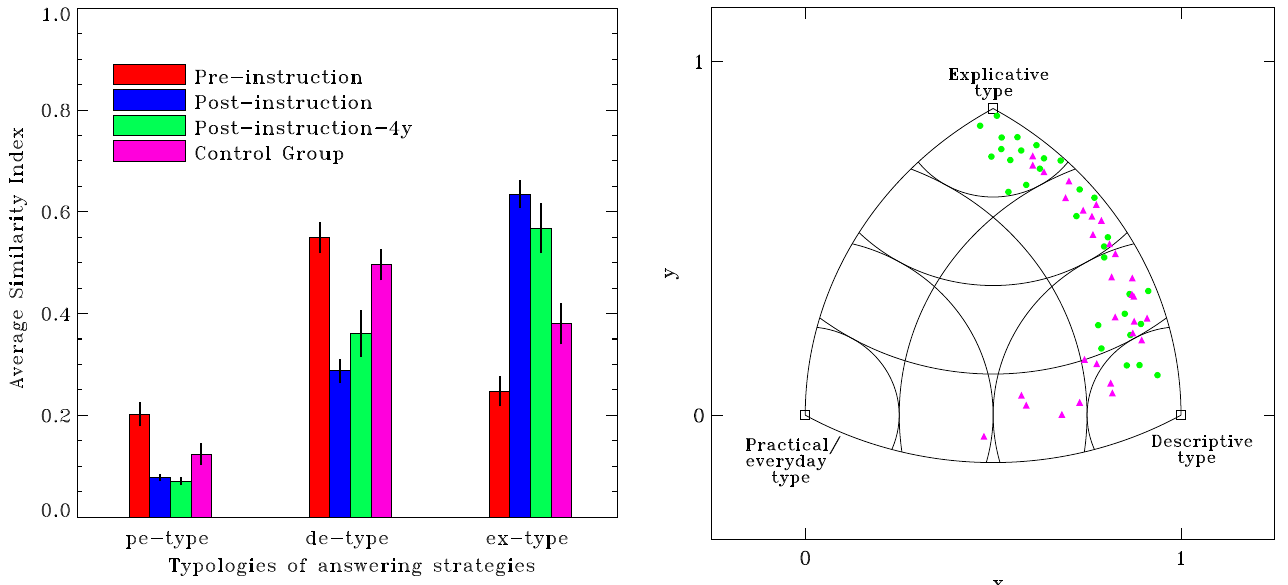
FIG. 1. Average similarity index of student answering strategies with pe-type, de-type, or ex-type profiles to address the ques- tionnaire, administered before (red bars), just after instruction (blue bars) and four years after participating the OI-based experience (green bars), in comparison with the results obtained by the control group (purple bars).